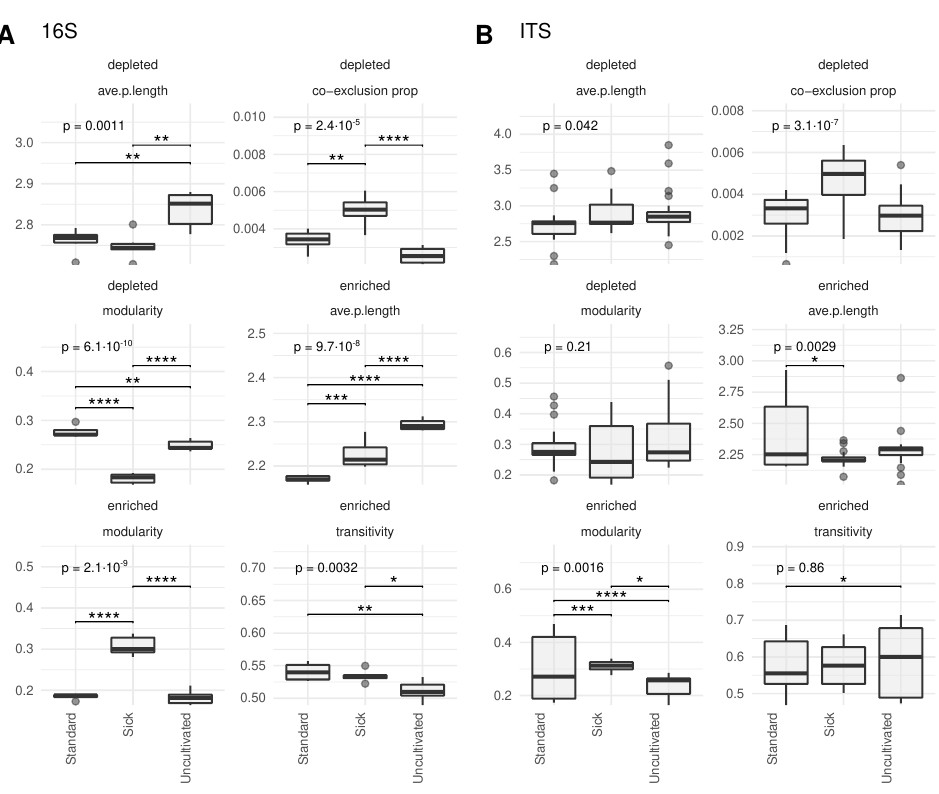
Figure 4. Network properties on co-occurrence (enriched) and co-exclusion (depleted) 16S ( A ) and ITS ( B ) metanetworks. Network properties comparison between soils showing contrasting track of agricultural conditions before the treatments. p -values show the statistical significance of ANOVA analyses while significance of post-hoc comparisons among groups are indicated as follows * ( p -value < 0.05), ** ( p -value < 0.005), *** ( p -value < 0.0005), **** ( p -value <